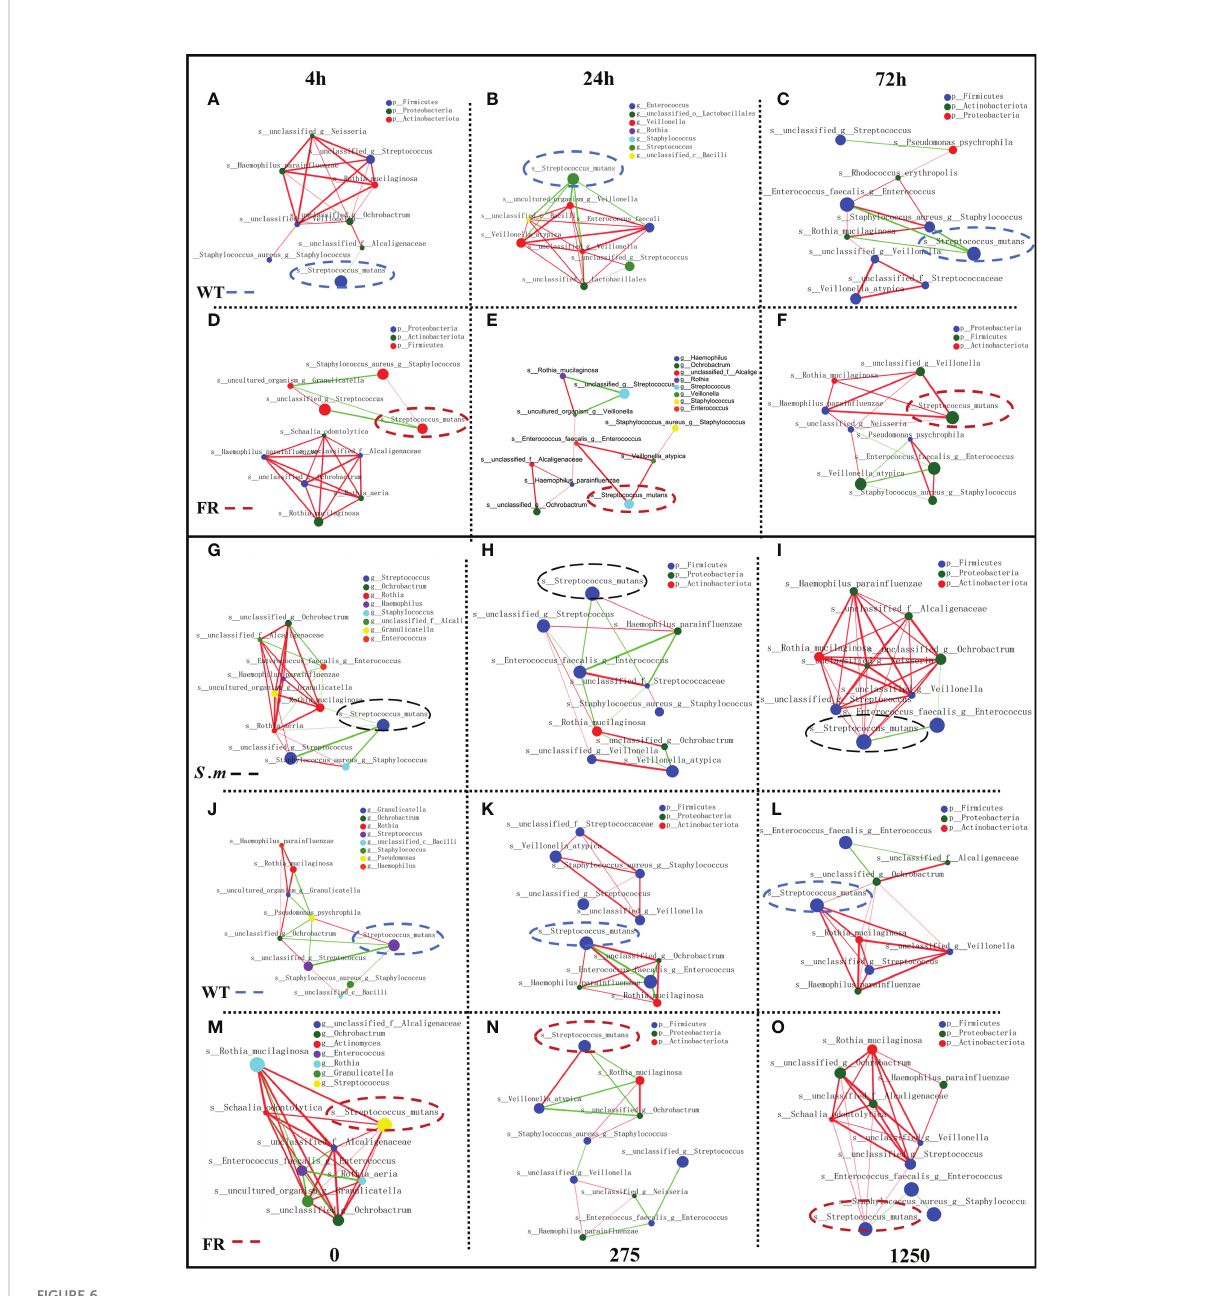
FIGURE 6 Network inferences of microbial relationships in oral bio fi lms with the presence of WT/FR. Each node represents an OTU, and each edge represents a signi fi cant pairwise association. Green lines represent negative relationships, and red lines represent positive relationships. (A-C) The network inferences of microbial relationships separately at different incubating times among bio fi lms with WT, standing at 4, 24, and 72 h. (D-F) The network inferences of microbial relationships separately at different incubating times among bio fi lms with FR, standing at 4, 24, and 72 h. (G-I) The network inferences of microbial relationships respectively at distinctive concentrations of NaF in bio fi lms with the presence of S. mutans , representing 0, 275, and 1,250 ppm. (J-L) The network inferences of microbial relationships respectively at distinctive concentrations of NaF in bio fi lms with the presence of WT, representing 0, 275, and 1,250 ppm. (M-O) The network inferences of microbial relationships respectively at distinctive concentrations of NaF in bio fi lms with the presence of FR, representing 0, 275, and 1,250